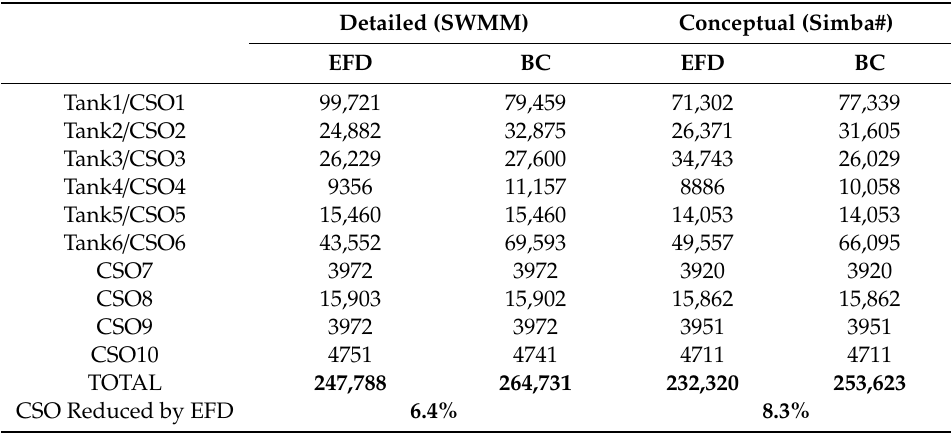
Table 5. Simulated CSO volumes (m 3 ) for di ff erent control scenarios (EFD and BC) obtained by the detailed (SWMM) and conceptual (Simba#)